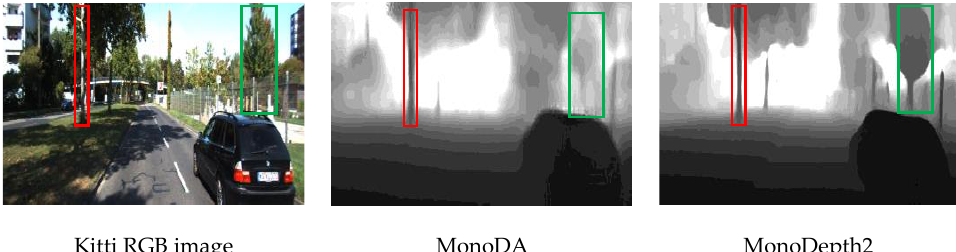
lighter gray (the right of Figure 7). On the contrary, our model gives the bags dark gray